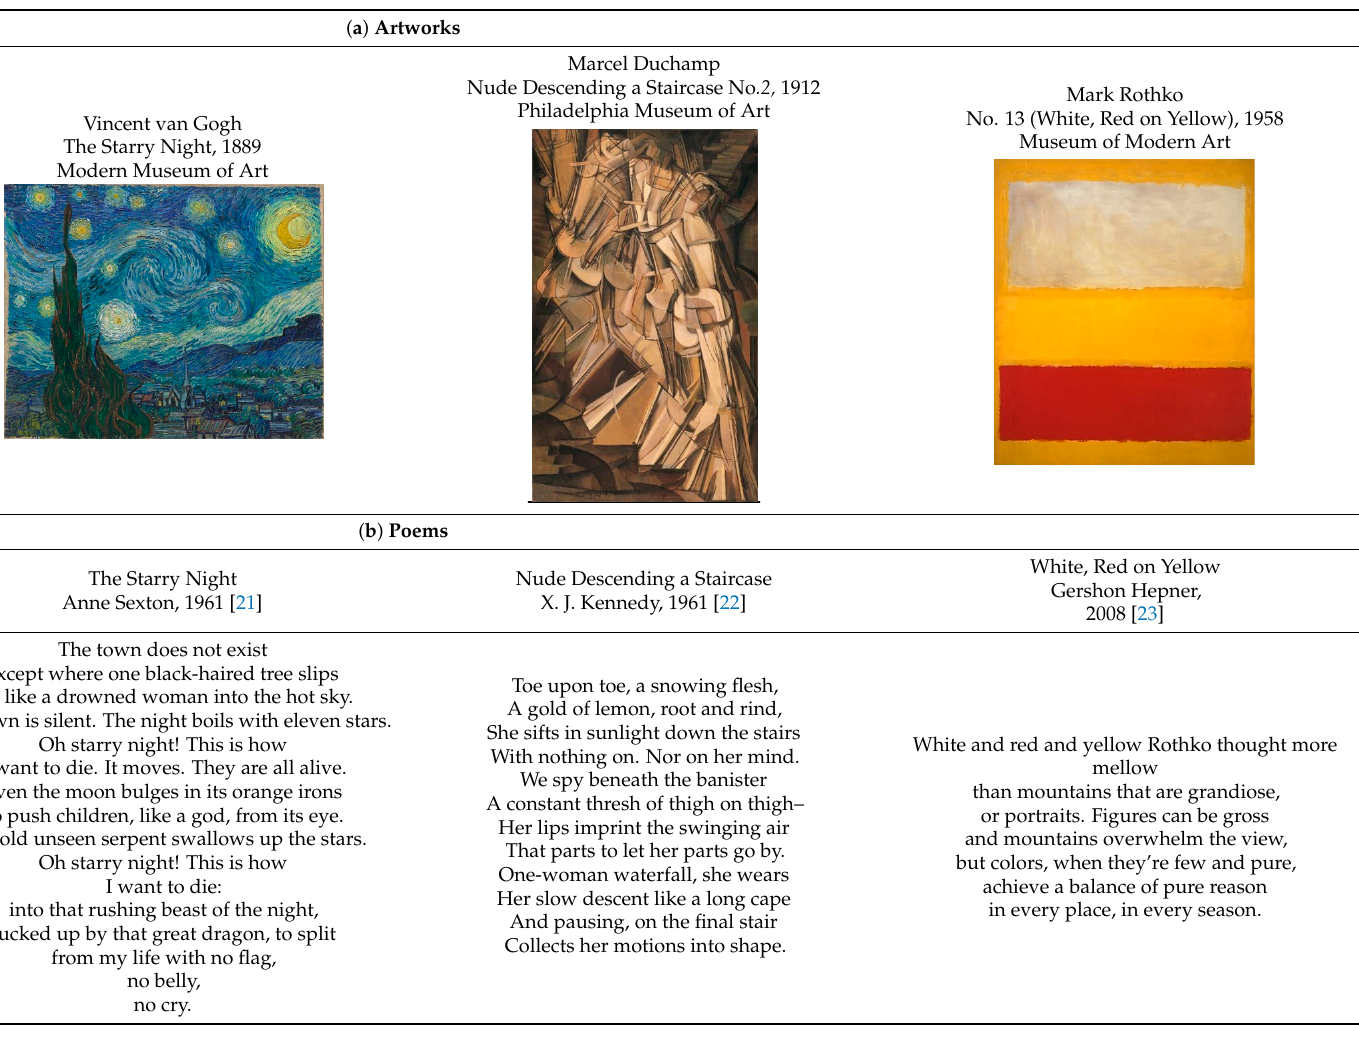
Table 1. Examples of ekphrasis ( a ): artworks, ( b ): poems.